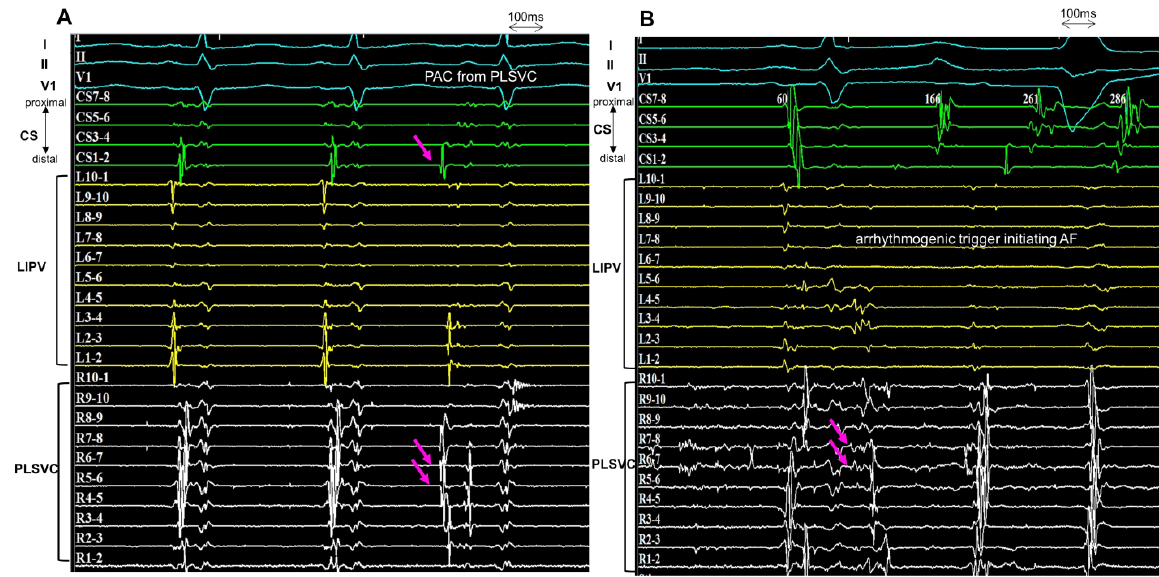
Figure 4. Arrhythmogenic trigger from PLSVC. ( A ): The circular mapping catheters are positioned within the LIPV and PLSVC. During the first two sinus beats, the two components (left atrial far-field and PLSVC potential) are fused. During the ectopic rhythm (the third beat), the sharp potential of the PLSVC precedes the surface ECG by 60 ms. The atrial activation sequence is from distal to proximal on the CS during the PAC. ( B ): During AF initiation, the sharp potential of the PLSVC precedes the PAC, and the PAC arising from the PLSVC initiates the AF. CS, coronary sinus; PLSVC, persistent left vena cava; LIPV, left inferior pulmonary vein; PAC, premature atrial contraction; AF, atrial fibrillation.